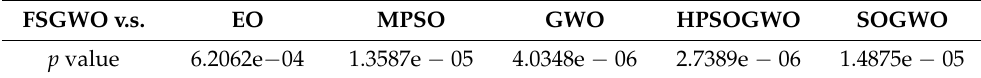
Table 6. Results of the Wilcoxon test for the mean values of Table 5. FSGWO